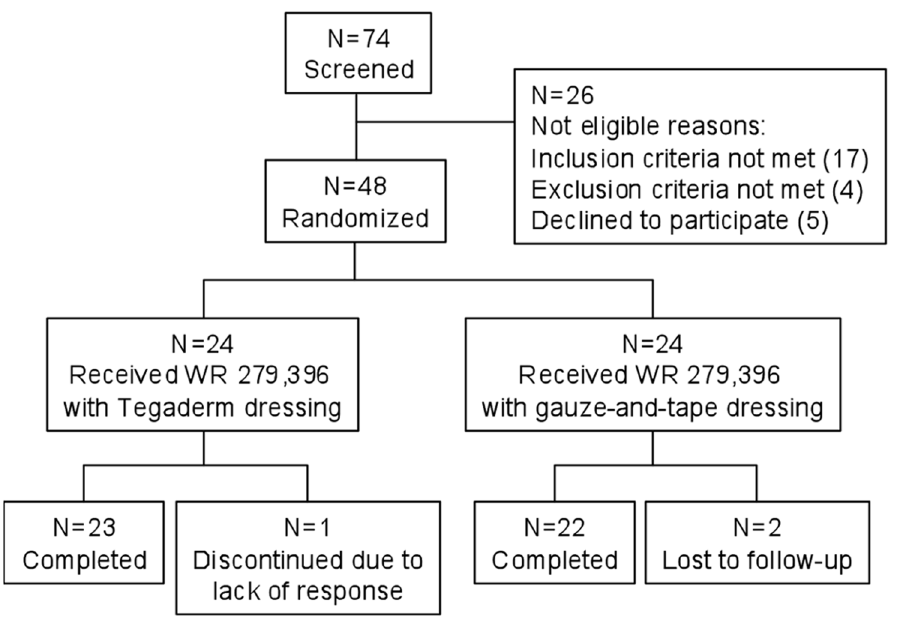
Figure 1. Summary of subject enrollment, treatment, and follow-up. Values are numbers of study subjects. Of the 74 subjects screened, 26 failed screening, most commonly due to having only one lesion that was already substantially healed (17 subjects). Forty-eight subjects were randomized, 24 in each study group. In the polyurethane group, one subject was discontinued due to an unsatisfactory result (enlargement of the index lesion at day 20). In the gauze-and-tape group, two subjects failed to return to the study site and were lost to follow-up. Forty-seven of 48 randomized subjects received a full 20-day course of WR 279,396 as planned in the protocol; one subject in the polyurethane group failed to return for further treatment after day 6.